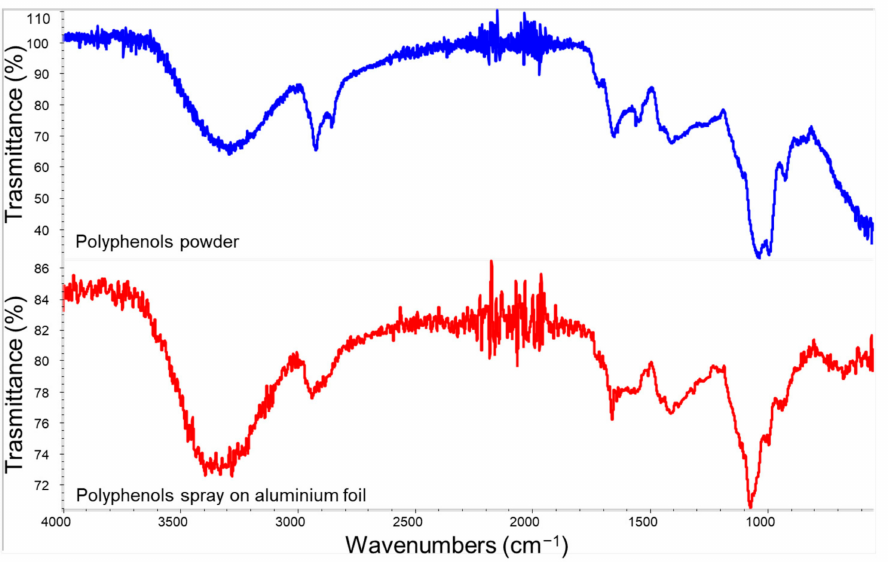
Figure 3. Spectra of polyphenols powder (top) and its sprayed film deposited on an aluminium foil. Typical peaks related to acetyl and amide groups of chitin were observed in the spectrum of Figure 4. C-H stretching was identified at 1850 cm − 1 , and the bands observed at 1548 cm − 1 , 1615 cm − 1 , and 1650 cm − 1 were typical of amide groups. N-H stretching band relatives to deacetylated groups of chitin were observed at 3270 cm − 1 . Other typical peaks related to the chitin carbohydrate backbone were the C-H stretching band shown at 2870–2880 cm − 1 , the O-H wide band at 3450 cm − 1 , and C-O-C stretching at 1025 and 1075 cm − 1 [77]. The comparison between ATR-FTIR results for ChNF powder and its spray on aluminium in Figure 4 evidenced a good correspondence between both